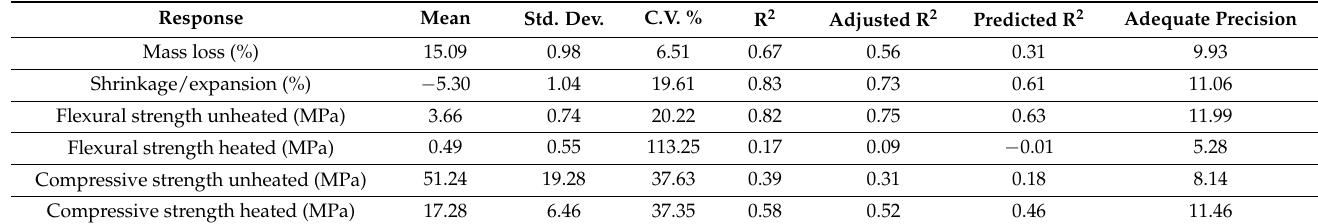
Table 6. Fit statistics for models.